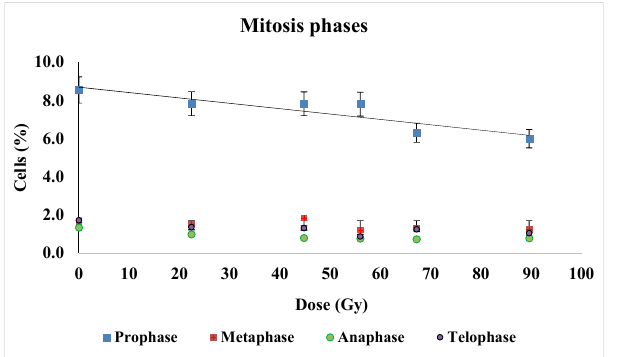
Figure 4. Cell percentage in mitosis phases in the proton beam irradiated samples at the Bragg peak. Average values and standard deviations were calculated for each experimental variant from five microscope slides that were analyzed, between 2300 and 3100 cells being found in each slide .